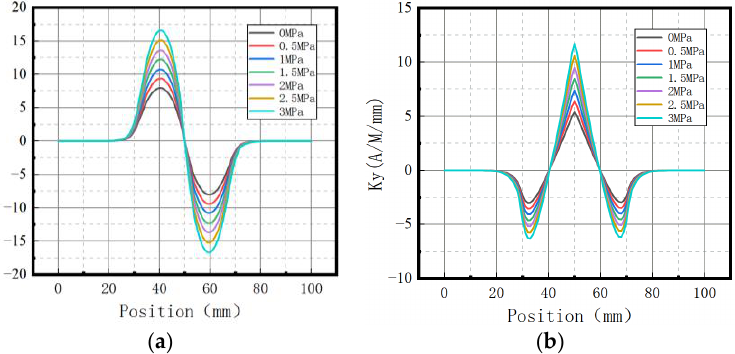
Figure 9. Magnetic signal gradient K variation with internal pressure. ( a ) The axial gradient compo- nent Kx; ( b ) the radial gradient component Ky.